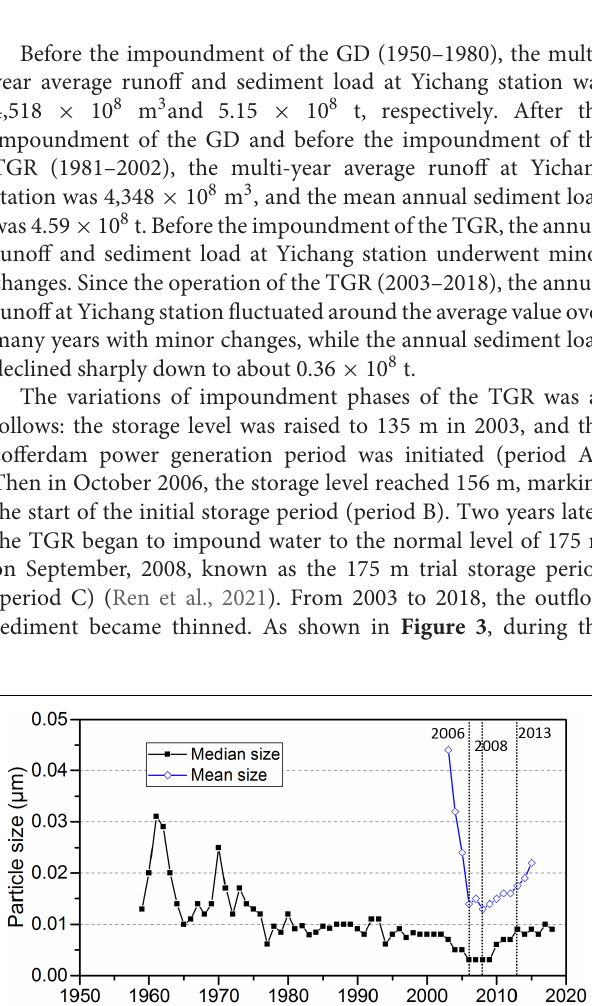
FIGURE 2 | Annual runoff and sediment load at Yichang station.